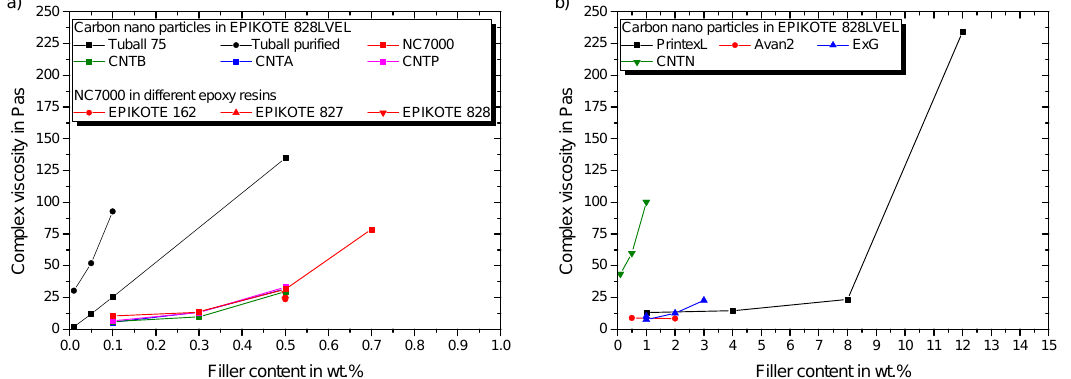
Figure 9. Impact of particle modification on the rheological properties for ( a ) evaluated MWCNT and SWCNT in epoxy resin with curing agent ( b ) evaluated planar particles, CB and CNTN in epoxy resin with curing